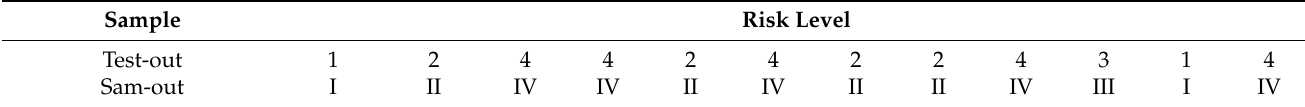
Table 7. Comparison table of prediction results and training